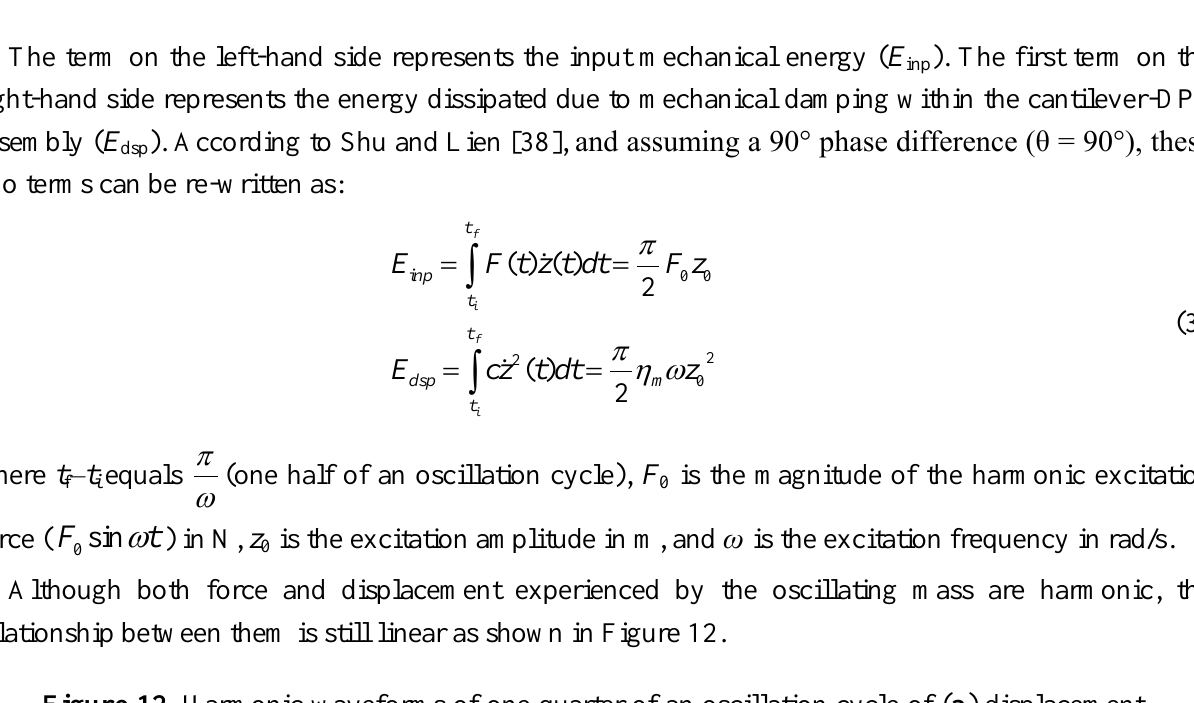
Figure 12. Harmonic waveforms of one quarter of an oscillation cycle of ( a ) displacement and ( b ) force; ( c ) Harmonic force versus